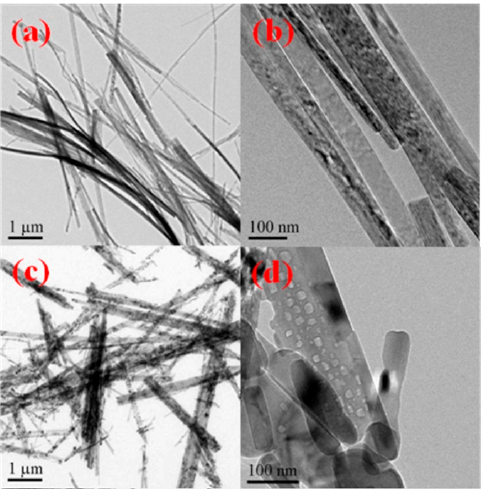
Figure 2. TEM images of sodium titanates before acid wash ( a , b ), and anatase TiO 2 nanorods after hydrothermal treatment by H 2 SO 4 ( c , d ).